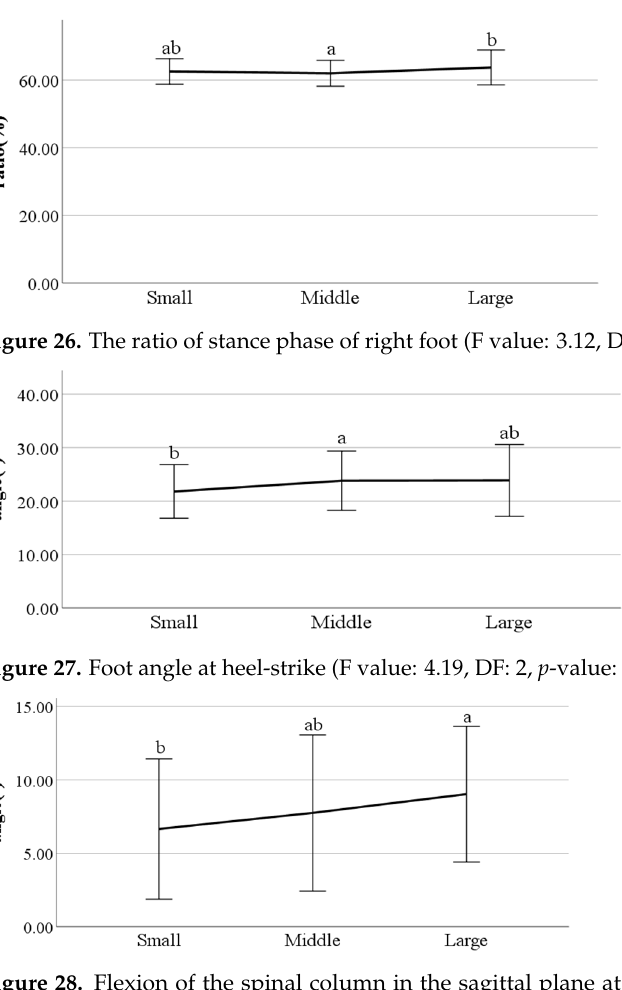
Figure 28. Flexion of the spinal column in the sagittal plane at heel-strike f (F value: 3.39, DF: 2, p - value: 0.04).